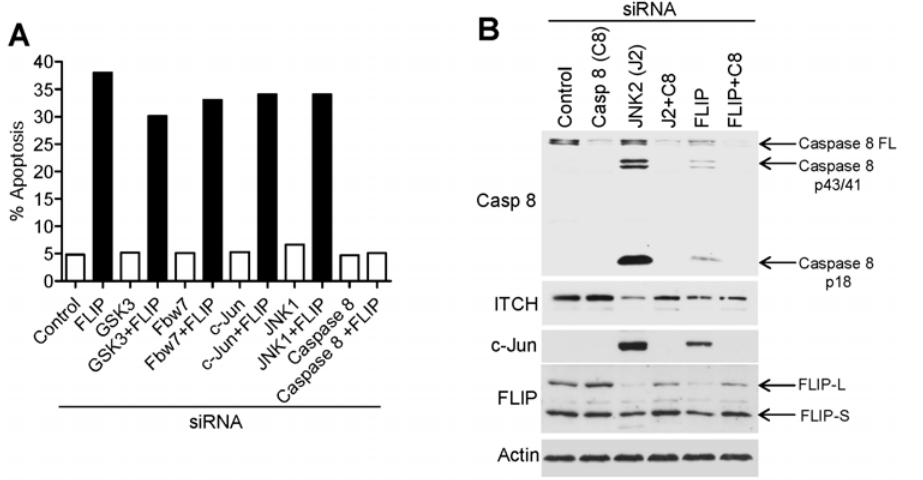
Figure 6. c-FLIP is an essential mediator of basal apoptosis in human cancer cells and functions downstream of GSK3, Fbw7, c-Jun and JNK1. (A) Levels of apoptosis observed following co-silencing of c-FLIP with pro-apoptotic mediators. (B) Protein levels showing pro-caspase 8 cleavage and c-Jun accumulation following c-FLIP depletion by RNAi.